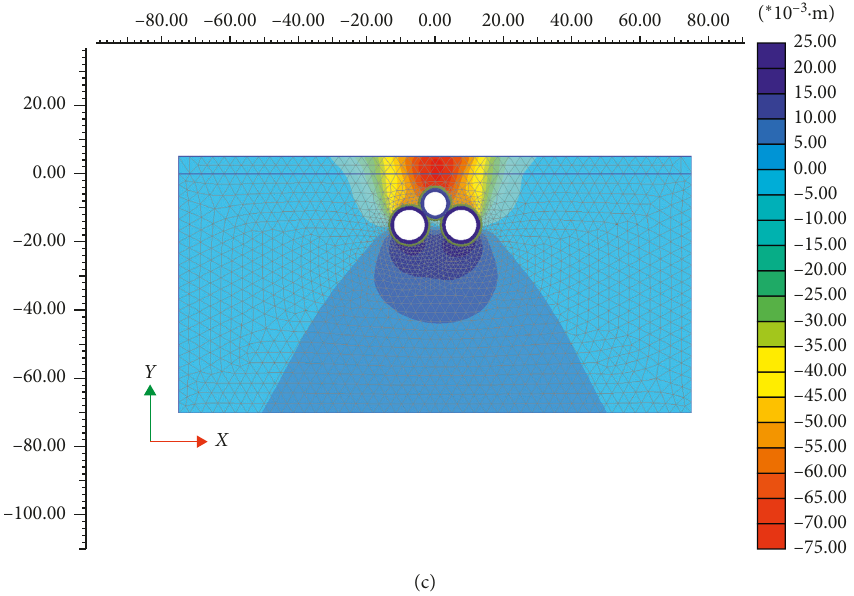
Figure 8: (a) Triplet tunnel configuration (dimensions in cm). (b) Settlement trough of Top-Left-Right tunnel sequence. (c) Displacement contours resulting from Top-Left-Right